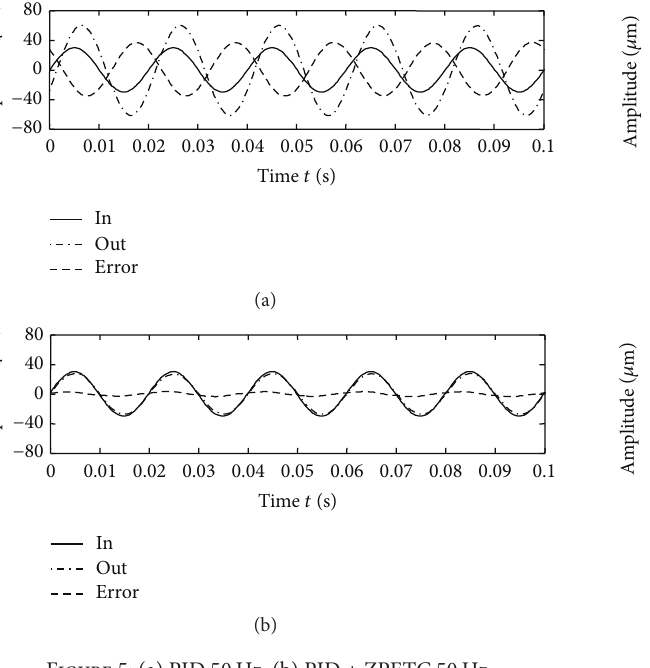
Figure 7: (a) PID 50 Hz. (b) PID + ZPETC 50